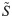
The IPRs of the eigenvectors.The x-axis represents the rank of eigenvectors νk. The y-axis represents the corresponding IPR I(k). The black circles and lines represent the I(k)s of the eigenvectors νk derived from the spreads set S˜. The green points represent the I(k)s of the eigenvectors derived from the shuffled data. The blue solid lines represents the mean values of the I(k)s derived from the shuffled data.